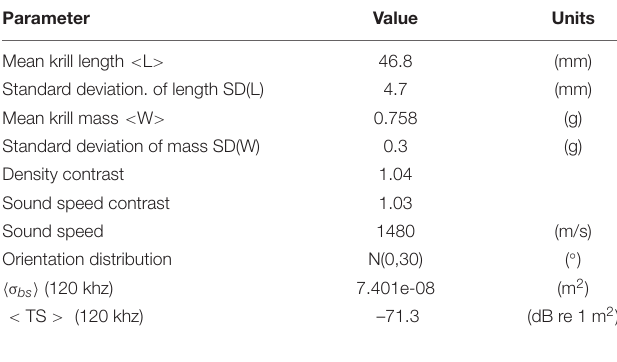
TABLE 3 | Parameters used for the DWBA model of krill target strength